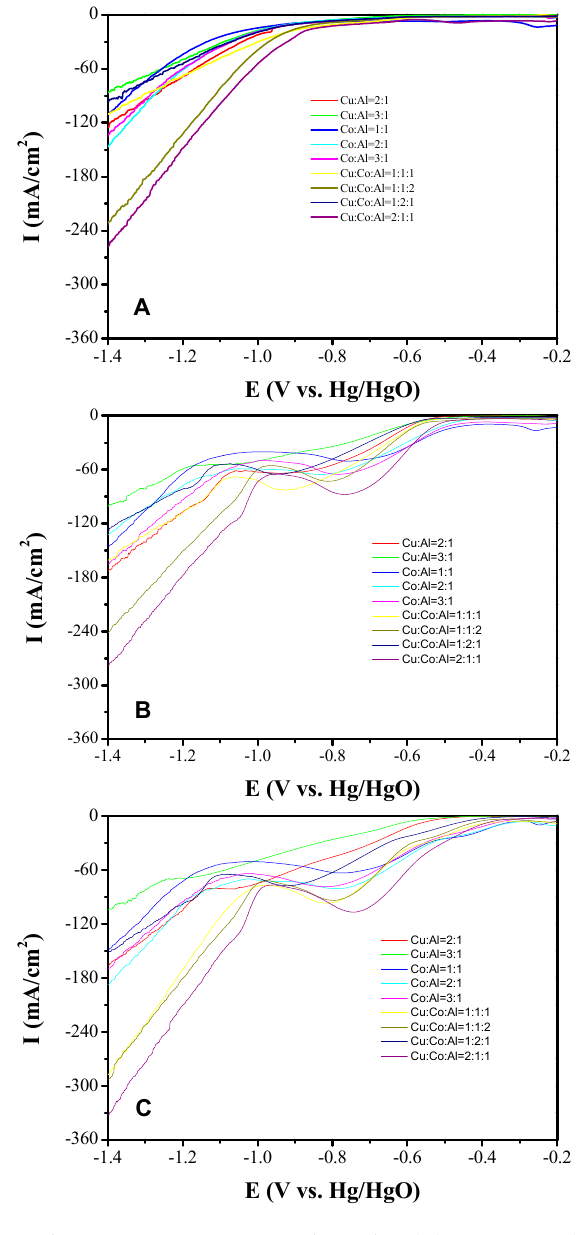
Figure 4. Linear sweep voltammograms on various electrodes: ( A ) 1 M NaOH; ( B ) 1 M NaOH + 0.1 M NaNO 2 ; ( C ) 1 M NaOH + 0.1 M NaNO 3.